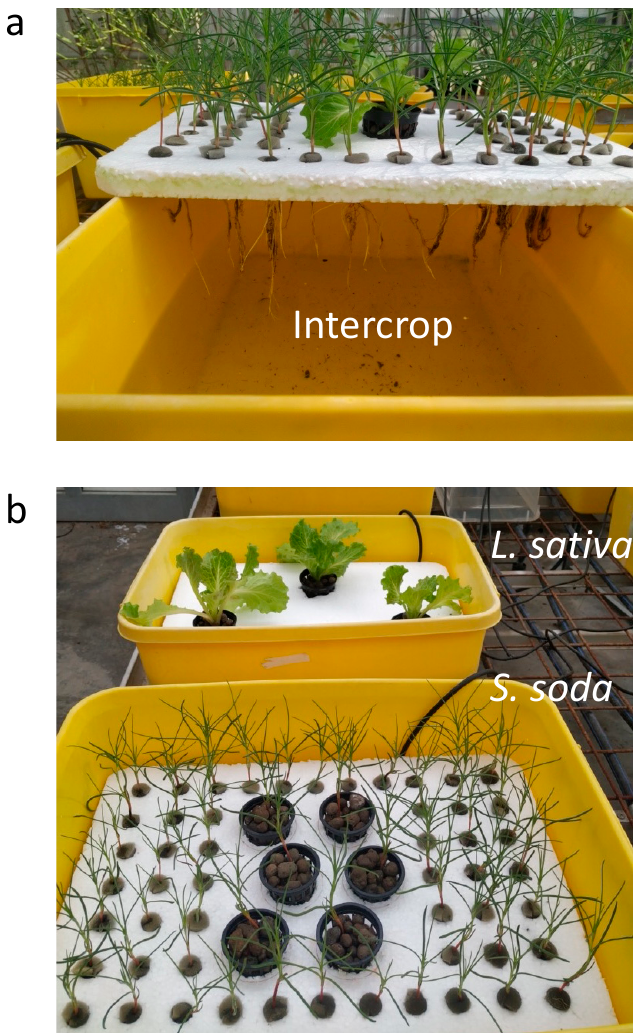
Figure 3. The experimental set-up for all three treatment groups at start of the trial: ( a ) intercrop and ( b ) L. sativa alone ( top ) and S. soda alone ( bottom